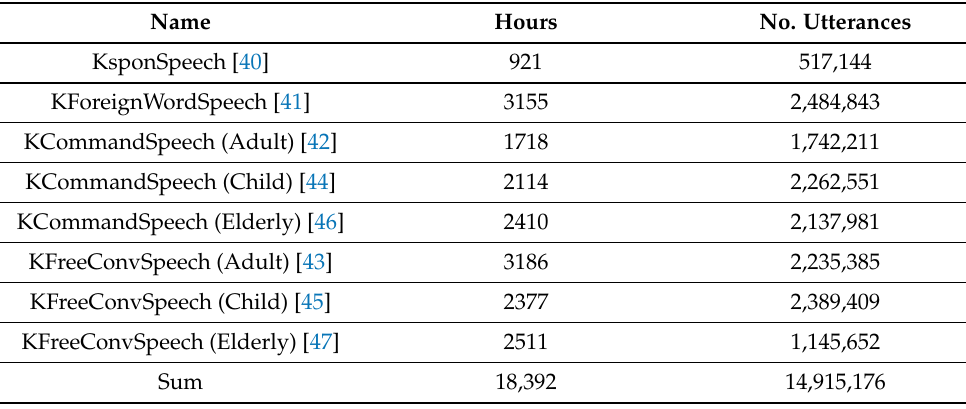
Table 1. Four Korean speech datasets for pretraining the SVR model.